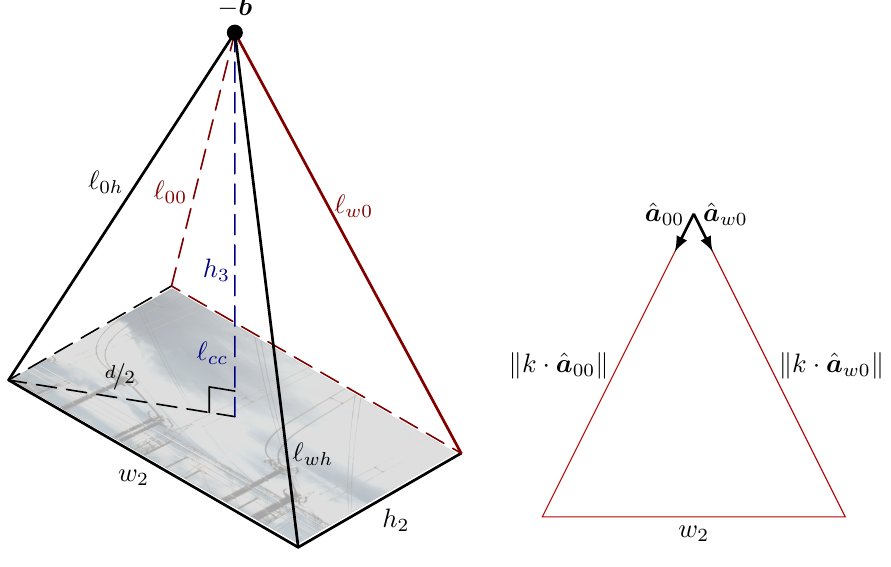
Figure 3. Elements for calculating h 3